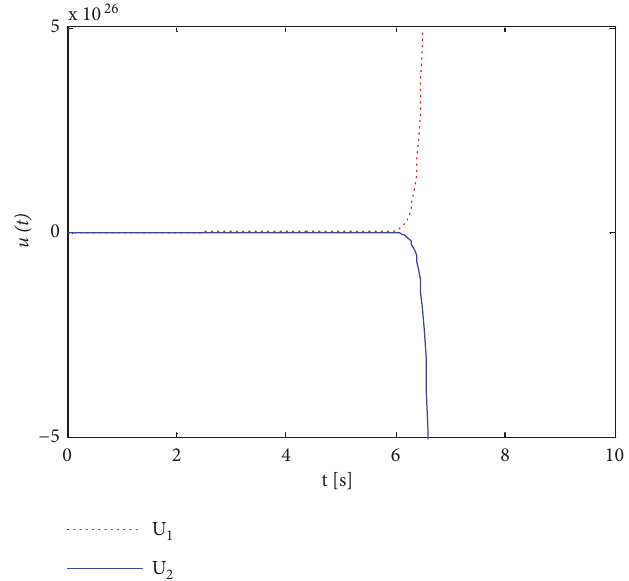
Figure 4: Control curve of memoryless state feedback